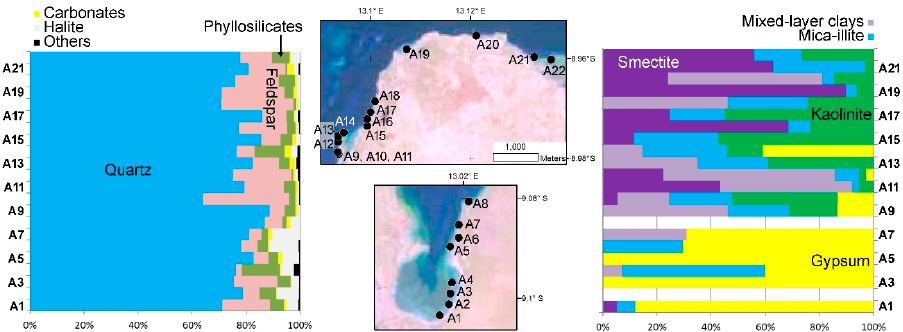
Figure 3. Bulk and clay mineral assemblages obtained for sediments of the Mussolo lagoon.